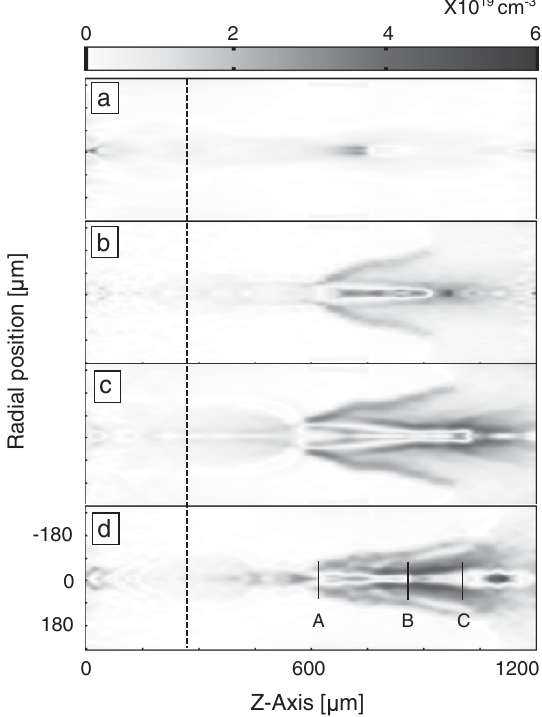
FIG. 8. Restored electron density distribution of the plasma channels for the laser power P ¼ 15 GW (the pulse energy of 90 mJ and pulse duration of 6 ps) and 1 : 5 (cid:3) 10 19 cm (cid:4) 3 gas density at different times. Parts (a)–(d) show the interferograms at different delays: (a) 1 ps, (b) 3 ps, (c) 5 ps, (d) 9 ps.